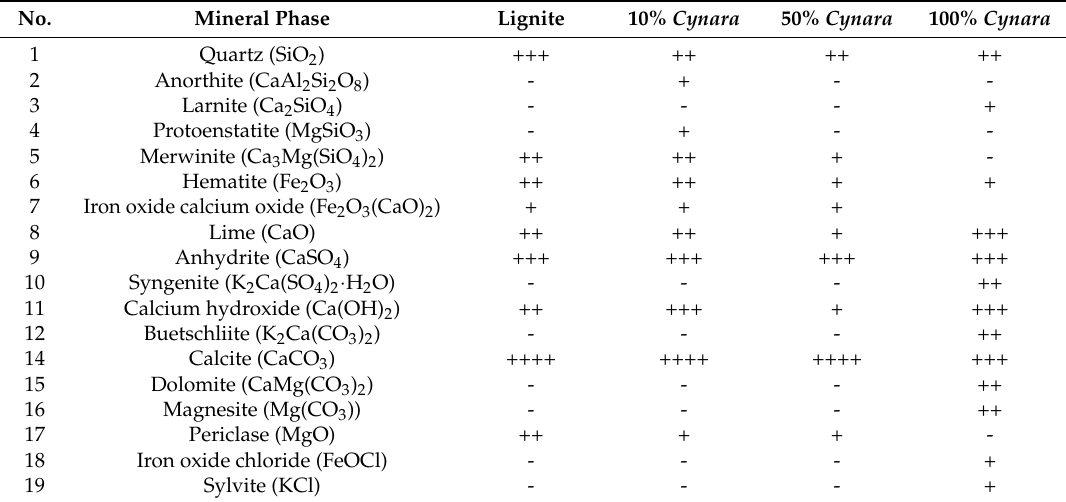
Table 7. X-ray powder diffraction analyses of the fly ashes from experimental